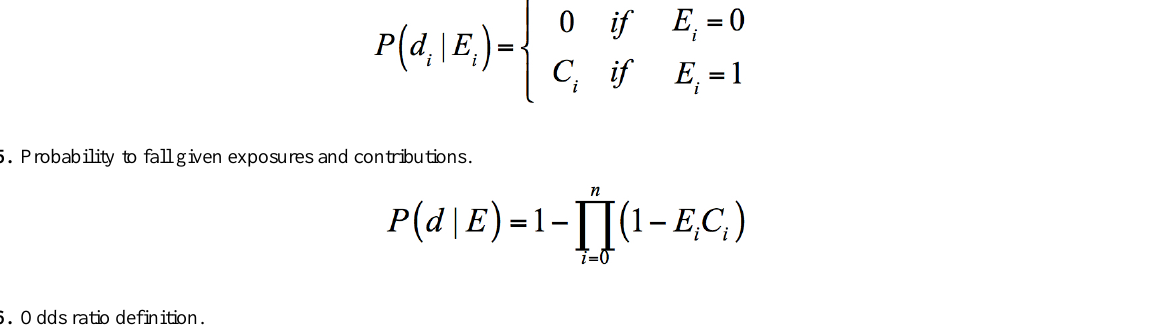
Figure 6. Odds ratio definition.